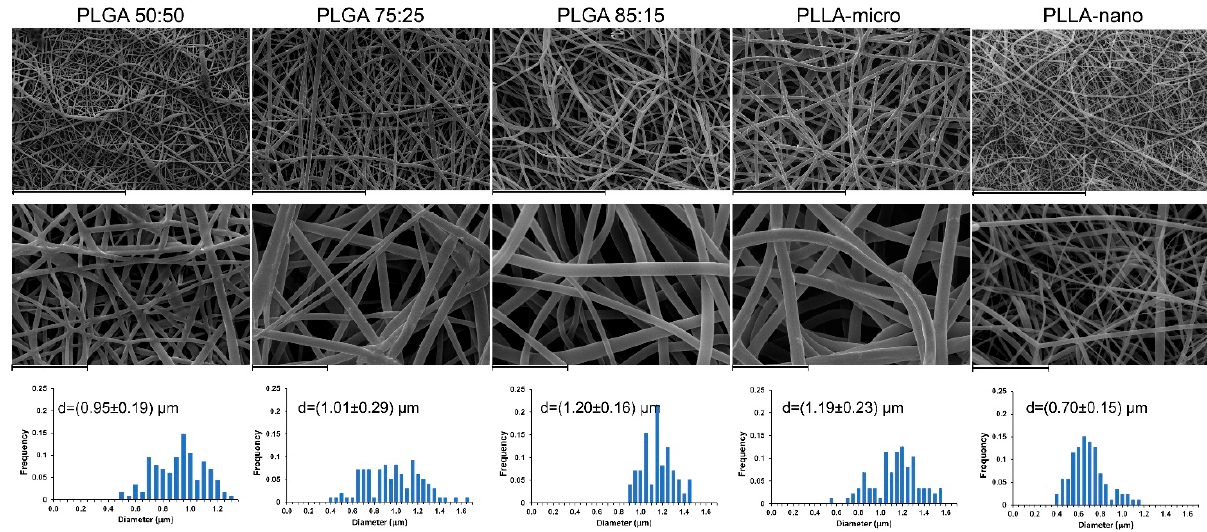
Figure 3. SEM images of the different electrospun scaffolds loaded with 5 wt% of Ibu at different magnifications and the corresponding fiber diameter distributions. Scale bars: 60 µm (first raw) and 10 µm (second raw).